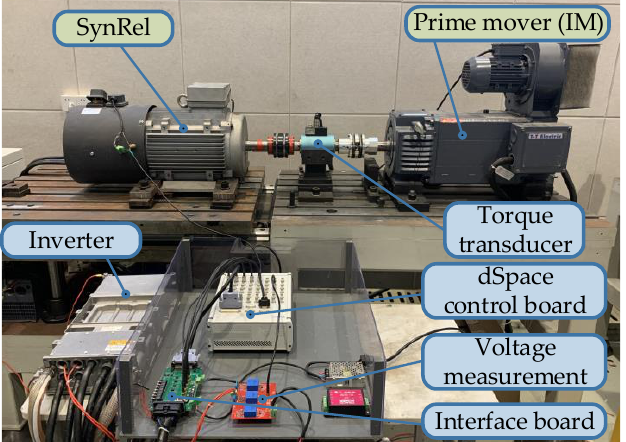
Figure 8. Test bench for magnetic model identification [23].